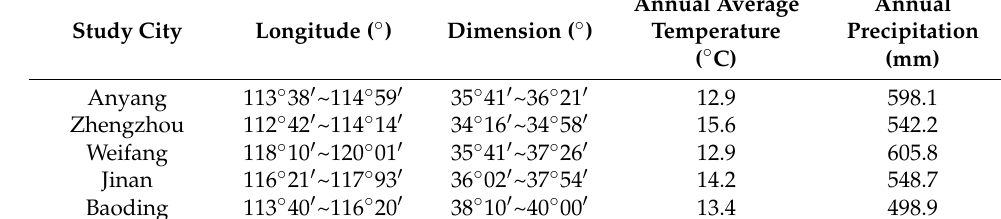
Annual Annual Average Precipitation Temperature ( ◦ C)